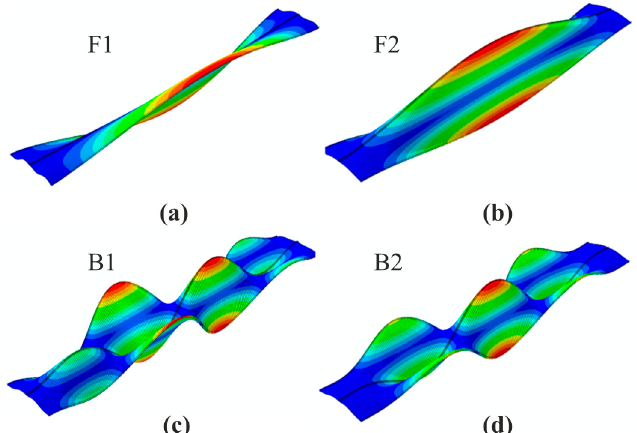
Figure 4. Initial geometrical imperfections: ( a ) first vibration mode; ( b ) second vibration mode; ( c ) first buckling mode; ( d ) second buckling mode.